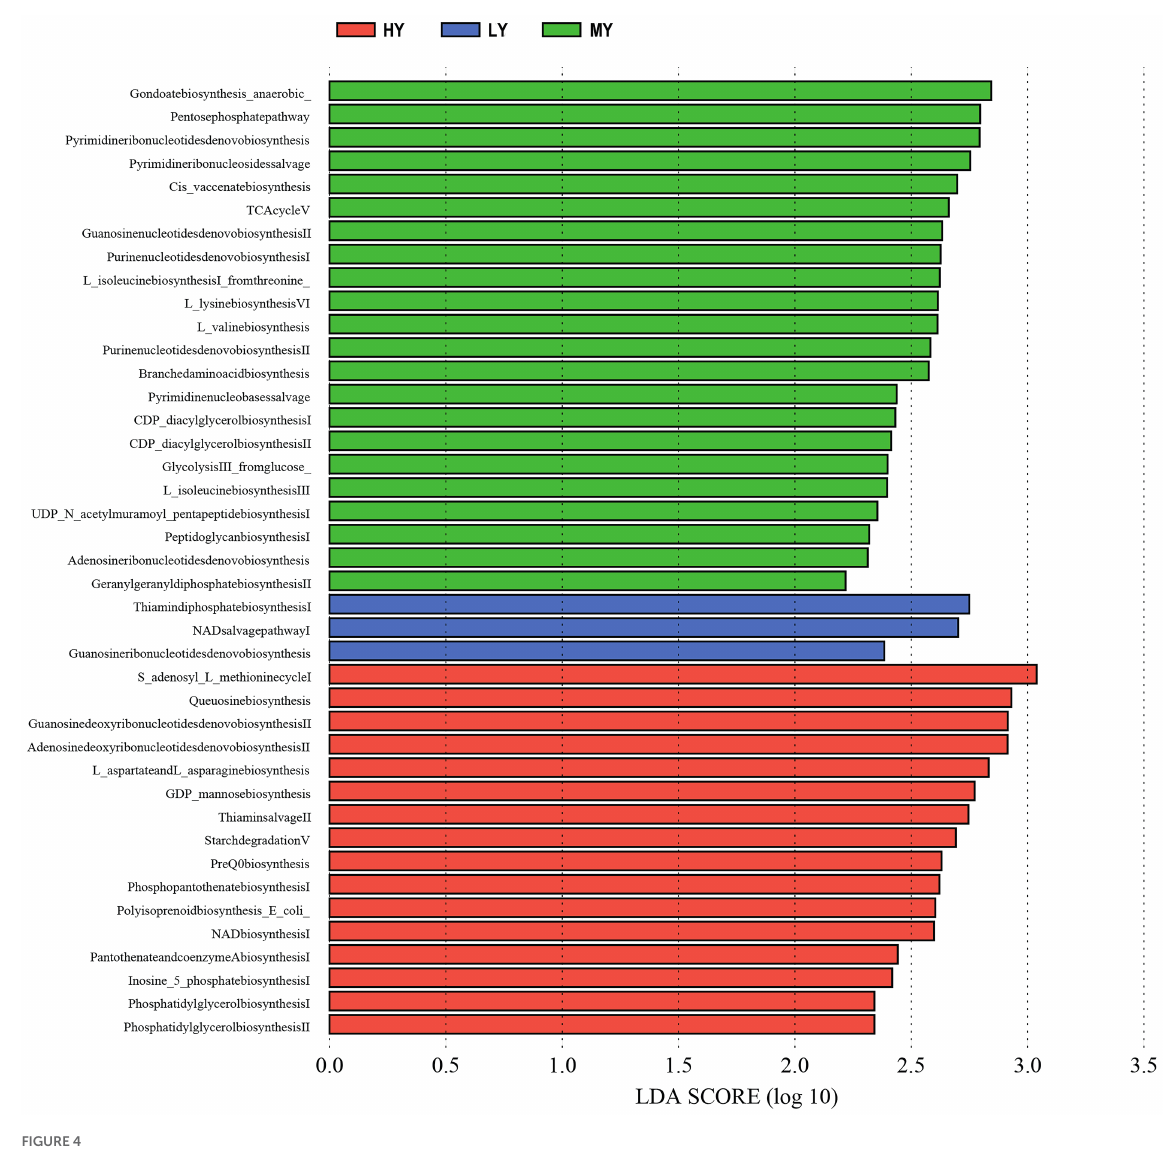
FIGURE 4 The correlation heat maps between the production performance index, rumen fermentation, blood biochemical indices, and significant different